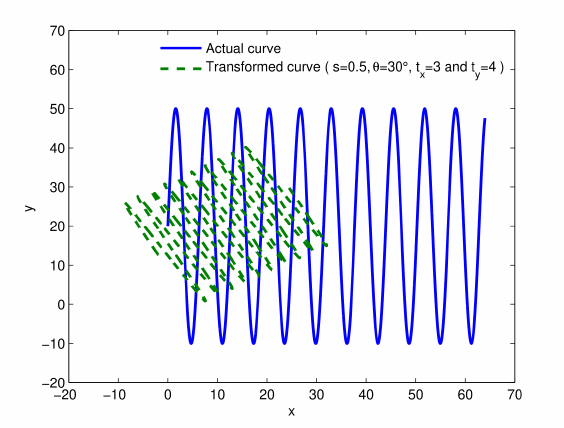
Fig. 1. f ( x ) = 30sin ( x ) + 20.